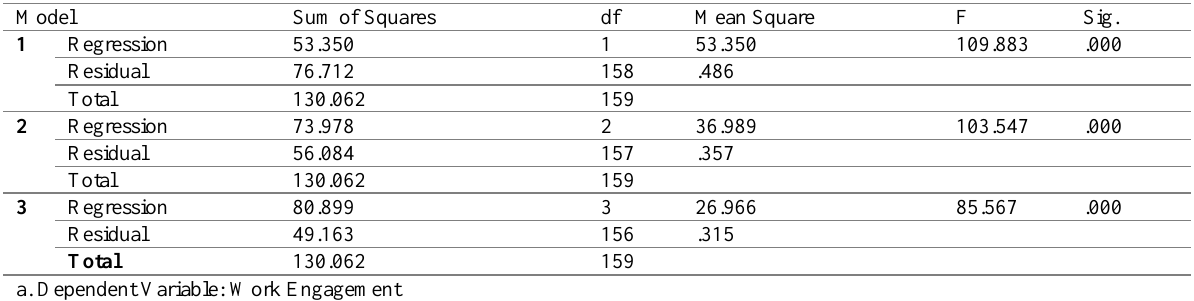
Table 9: ANOVA for the moderating effect of uncertain work environment Model Sum of